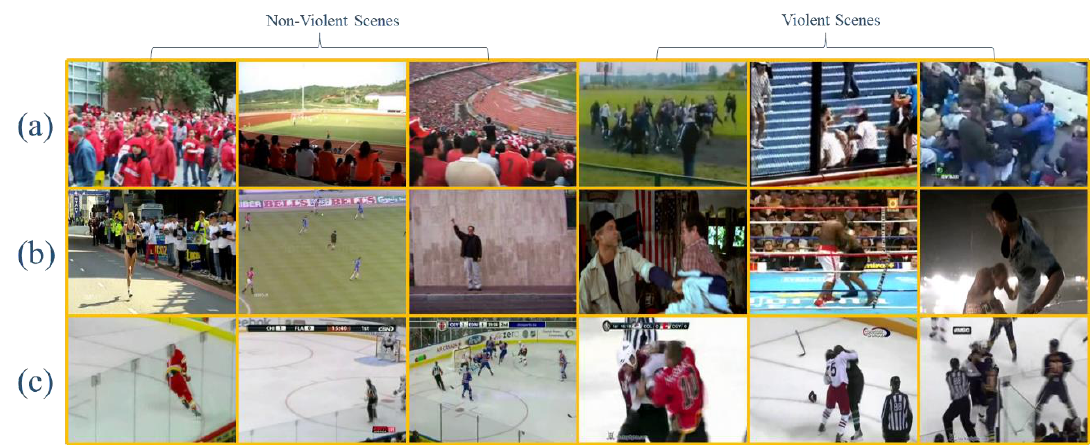
Figure 6. Sample video frames randomly selected from: ( a ) violent crowd [14], ( b ) violence in movies, [7] and ( c ) hockey fight [7].